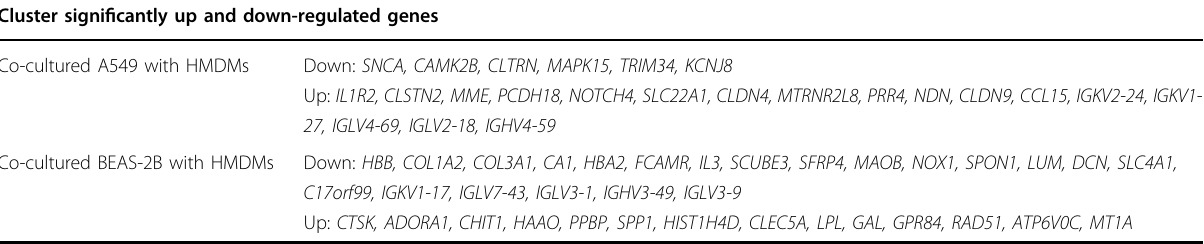
post-infection (Fig. 5j, m, p), IL-17A and TNF- α 4 days post-infection (Fig. 5k, l), and IL-1 β , CCL2 and CCL5 7 days post-infection in the lung of IL-38-treated mice (Fig. 5i, n, o), compared with mice without IL-38 administration. In the context of lower in fl ammation,